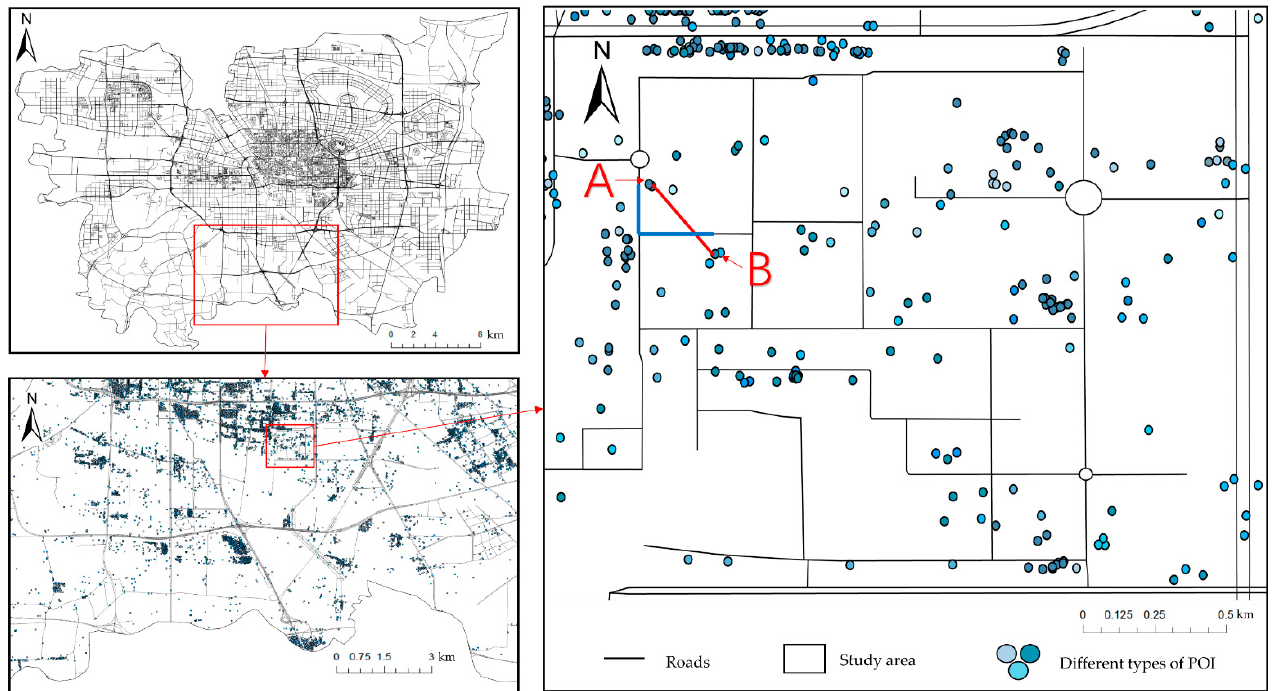
Figure 5. Distribution of POIs in the road network.